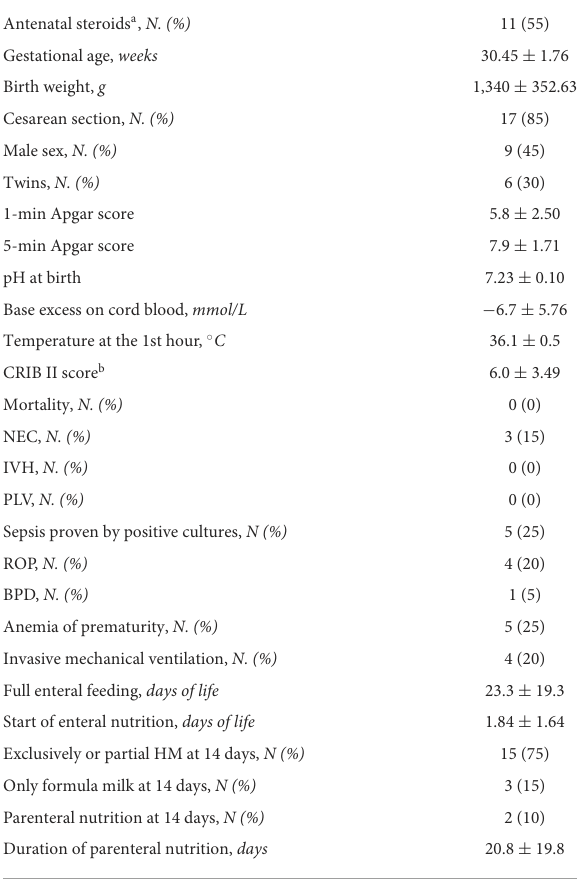
TABLE 1 Clinical characteristics of the study